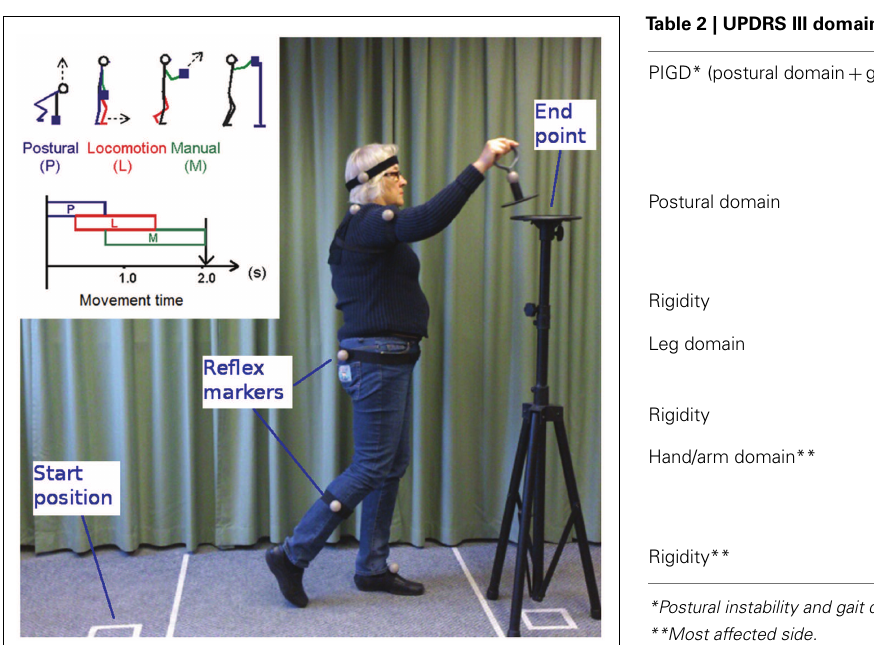
FIGURE 1 | Illustration of the PLM method .